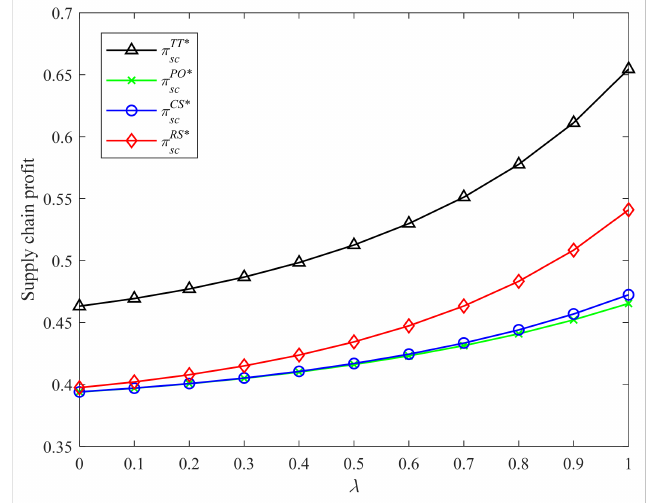
Figure 4. Comparison of the supply chain profits with different λ .